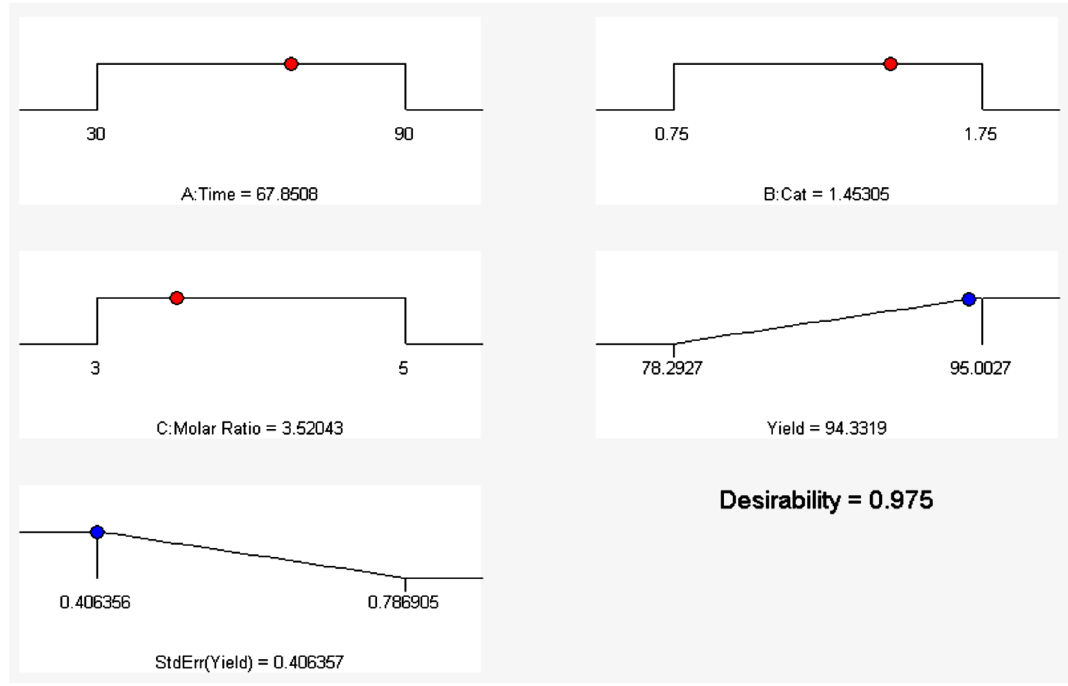
Figure 10. Optimization of parameters affecting the bio-lubricant reaction.